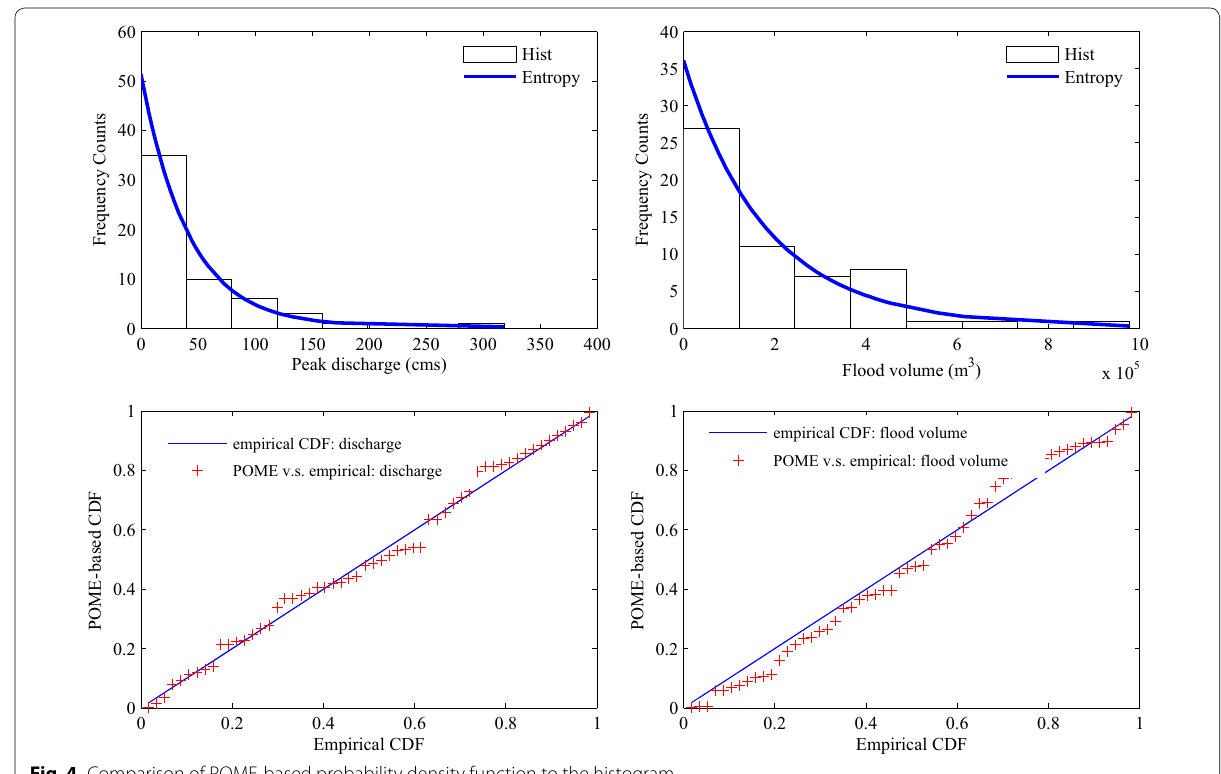
Fig. 4 Comparison of POME-based probability density function to the